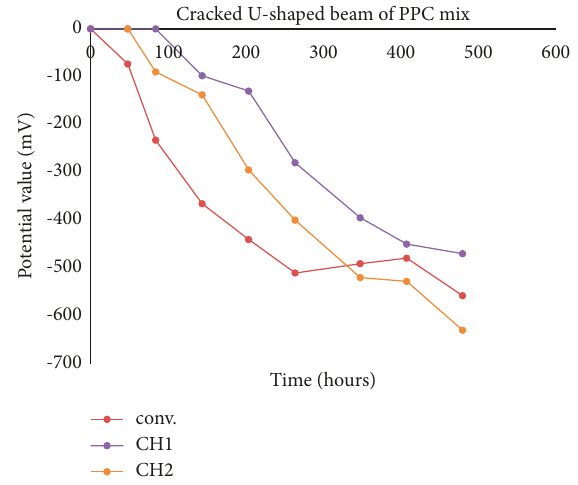
Figure 10: Cracked U-shaped beam of PPC mix.